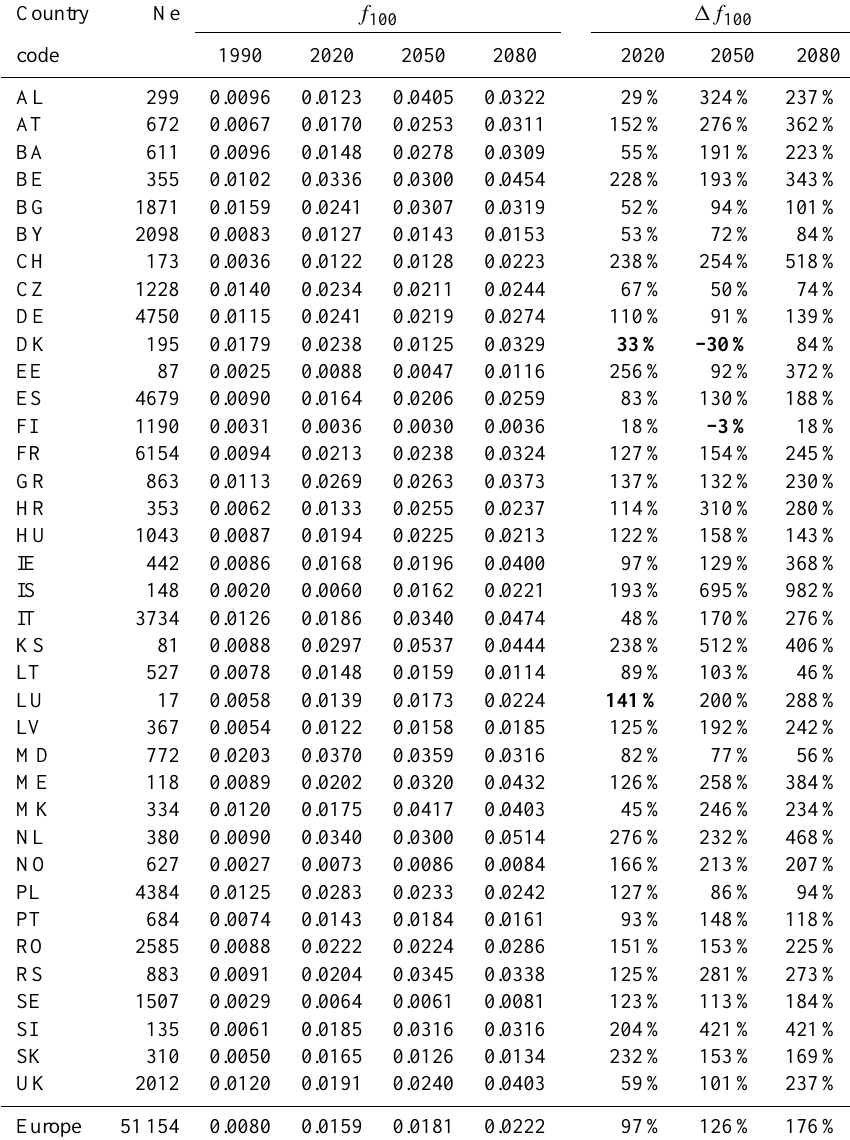
Table 2. Mean annual exceedance frequency of the 100-year return period peak flow for different European countries and percentage change between the baseline and the future time slices. Changes in bold are not significant at